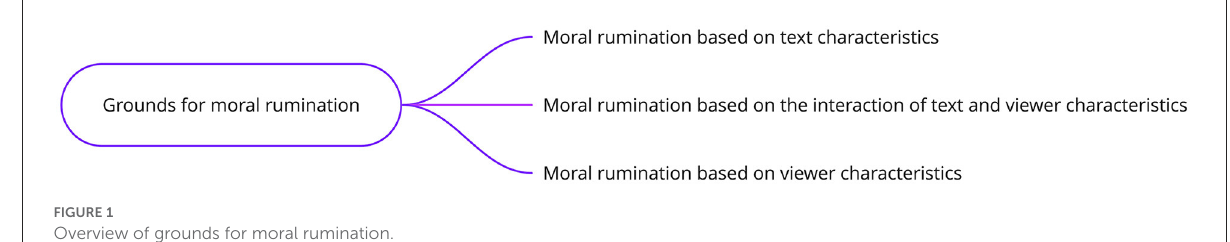
FIGURE1 Overview of grounds for moral